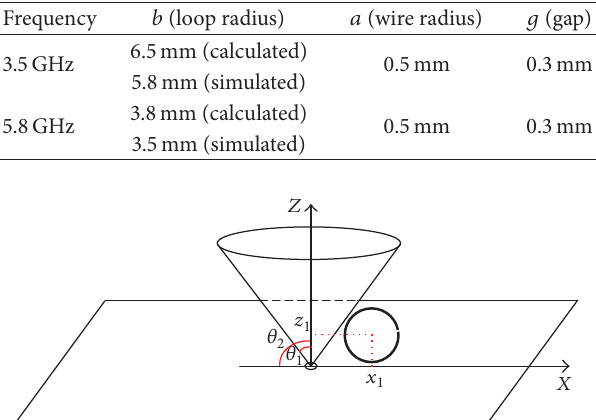
Table 1: Dimension of split loop.